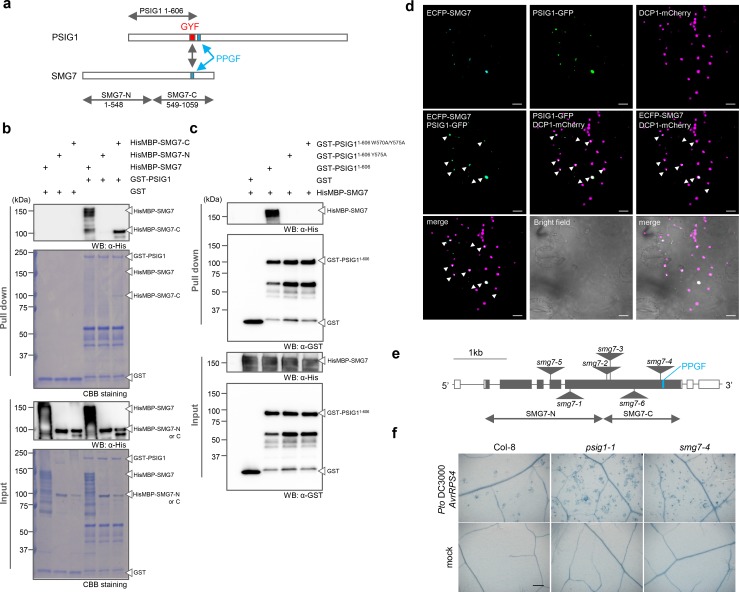
PSIG1 interacts with SMG7.a, Schematic structure of PSIG1 and SMG7. b, PSIG1 physically interacts with the C-terminus of SMG7 in vitro. HisMBP-SMG7, HisMBP-SMG7-N or HisMBP-SMG7-C were incubated with GST or GST-PSIG1 and the conjugates were pulled down with Glutathione-Sepharose beads. HisMBP-SMG7, HisMBP-SMG7-N, or HisMBP-SMG7-C were detected by immunoblotting using anti-His antibody. GST-PSIG1 was stained with Coomassie brilliant blue (CBB). Arrowheads indicate the position of each proteins. c, Tyr-575 of PSIG1 is required for interaction with SMG7 in vitro. HisMBP-SMG7 was incubated with GST, GST-PSIG1 1–606, GST-PSIG1 1–606 Y575A, or GST-PSIG1 1–606 W570A/Y575A, and the conjugates were pulled down with Glutathione-Sepharose beads. HisMBP-SMG7 and GST-PSIG1 were detected by immunoblotting using anti-His antibody or anti-GST antibody. d, PSIG1 and SMG7 co-localize with DCP1, a P-body marker. The images show the CFP signal in cyan, the GFP signal in green, and the mCherry signal in magenta. The merged images indicate the overlay of two signals in yellow or purple and the overlay of three signals in white. White arrowheads indicate overlayed signals. Cellular localization was analyzed at 4 days after inoculation in agroinfiltrated Nicotiana benthamiana. The scale bars represent 10 μm. e, Genomic structure of the SMG7 gene. Black boxes indicate the coding region, and white boxes indicate the non-coding region. The PPGF sequence resides downstream of the T-DNA insertion site. f, Induction of RPS4-triggered cell death is pronounced in the smg7-4 mutant allele. Plants were spray inoculated with 1 x 108 c.f.u. ml-1 of Pto AvrRPS4, and dead cells were visualized by trypan blue staining 2 days after inoculation. The scale bar represents 200 μm.